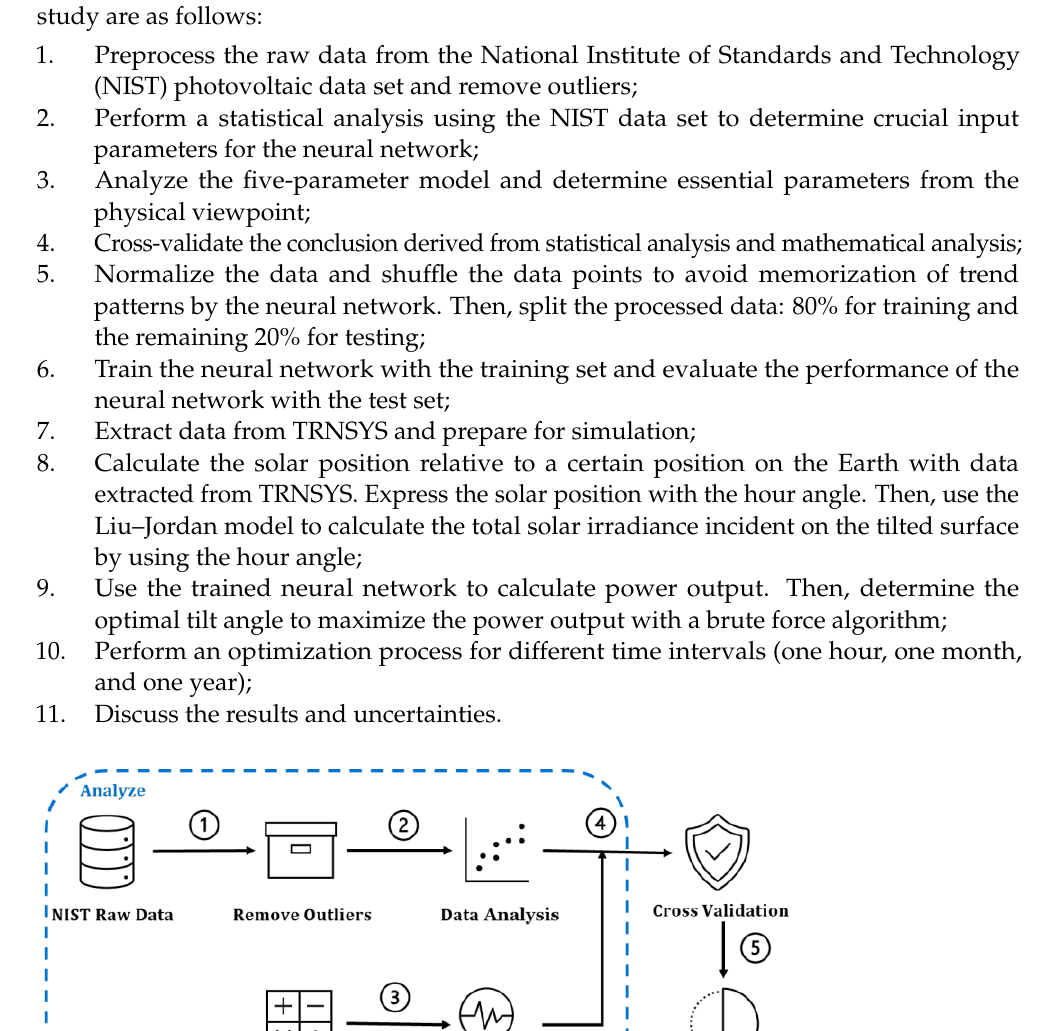
Figure 1. ( a ) Schematic of energy flow and ( b ) functional relationship of model parameters.